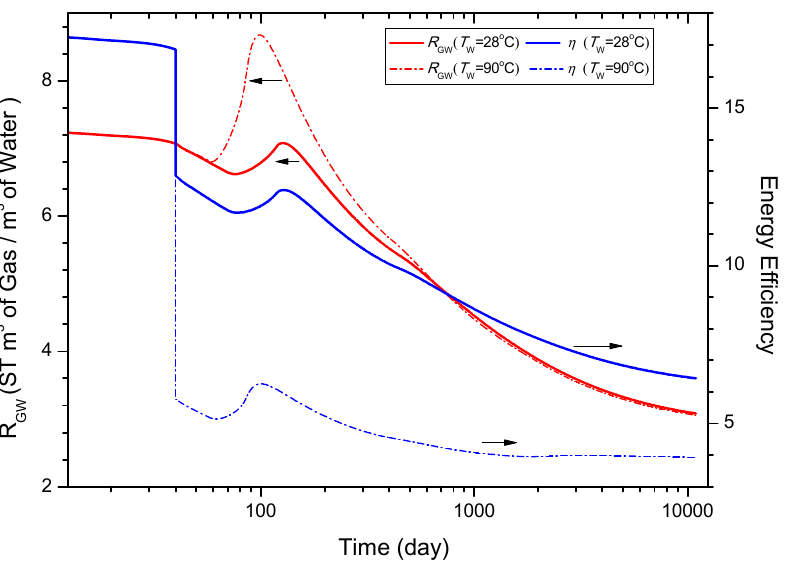
Figure 12. Evolution of the energy efficiency η , the gas-to-water ratio R dependence on the temperature of the injected brine during hydrate